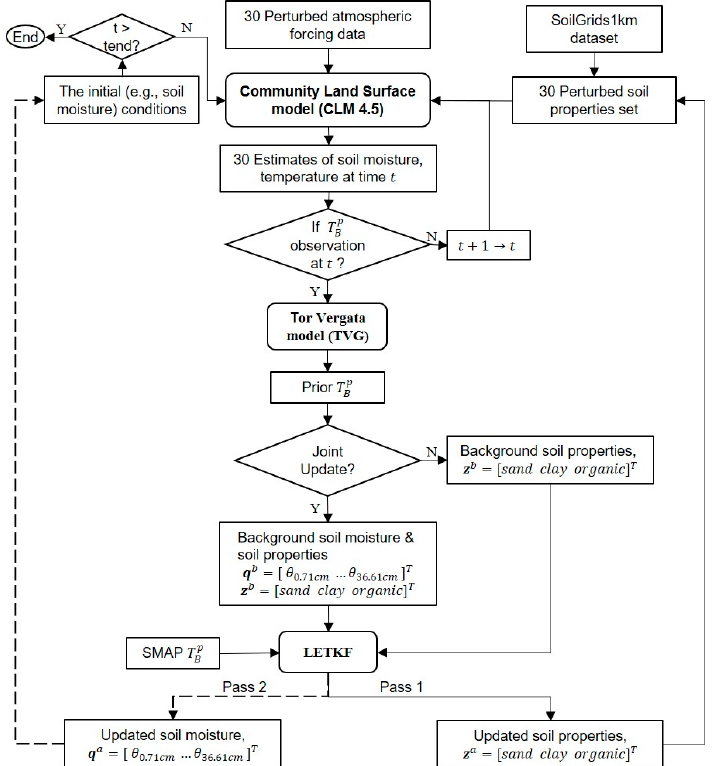
Figure 2. Flowchart of the retrieval of basic soil physical properties and the update of soil moisture in the DasPy data assimilation system. The rounded rectangles indicate the following four parts: the system model CLM, observation operator TVG model, LETKF data assimilation algorithm and SMAP T p observations. The black arrows denote forward flows in soil property retrieval and the dash arrows denote soil moisture update. t denotes time, t + 1 is the next time step, and the ensemble size is 30. (Note: in the only_Para experiment, only Pass1 is used; in the Joint_Updt experiment, both Pass1 and Pass2 are used to update values of the soil properties and SM, respectively.)